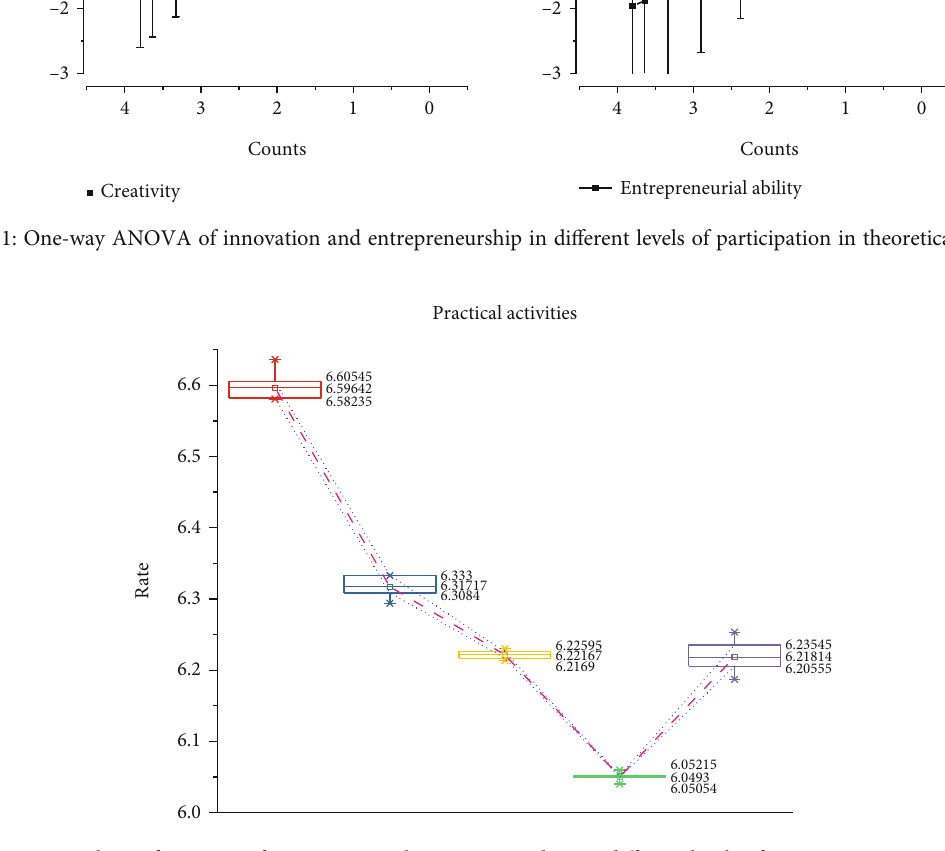
Figure 2: One-way analysis of variance of innovation and entrepreneurship on di ff erent levels of participation in practical